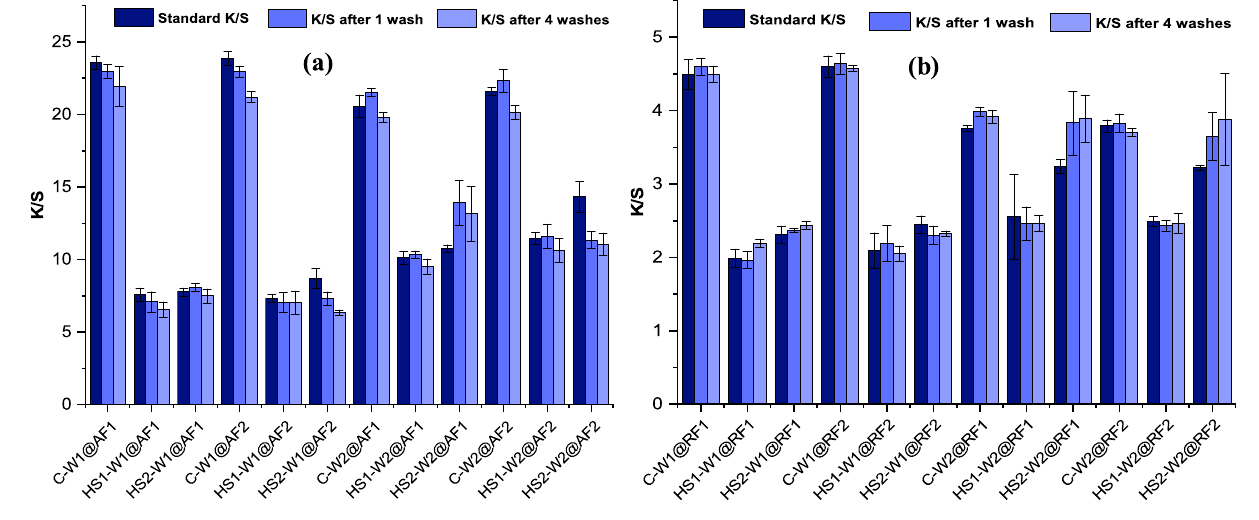
Figure 4. Fastness to washing based on color strength (K/S) measurement; ( a ) Acid dyed wool fabric; ( b ) Reactive dyed wool fabric ( = Standard K/S (left); = K/S after 1 wash (middle); = K/S after 4 washes (right)).